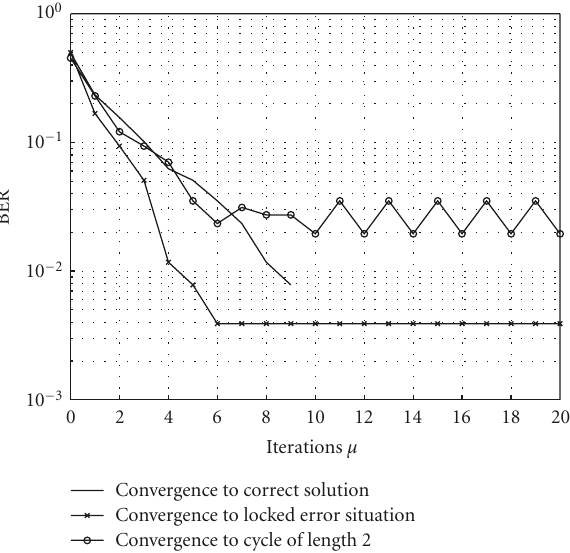
Figure 3: Possible convergence behavior for IHDIC with parallel ( E b / N 0 ) = 15dB, synchronous DS-CDMA update for 10 log 10 transmission over an AWGN channel with V = 128 users employing 4ASK and complex-valued random spreading sequences with spreading factor L = 256.